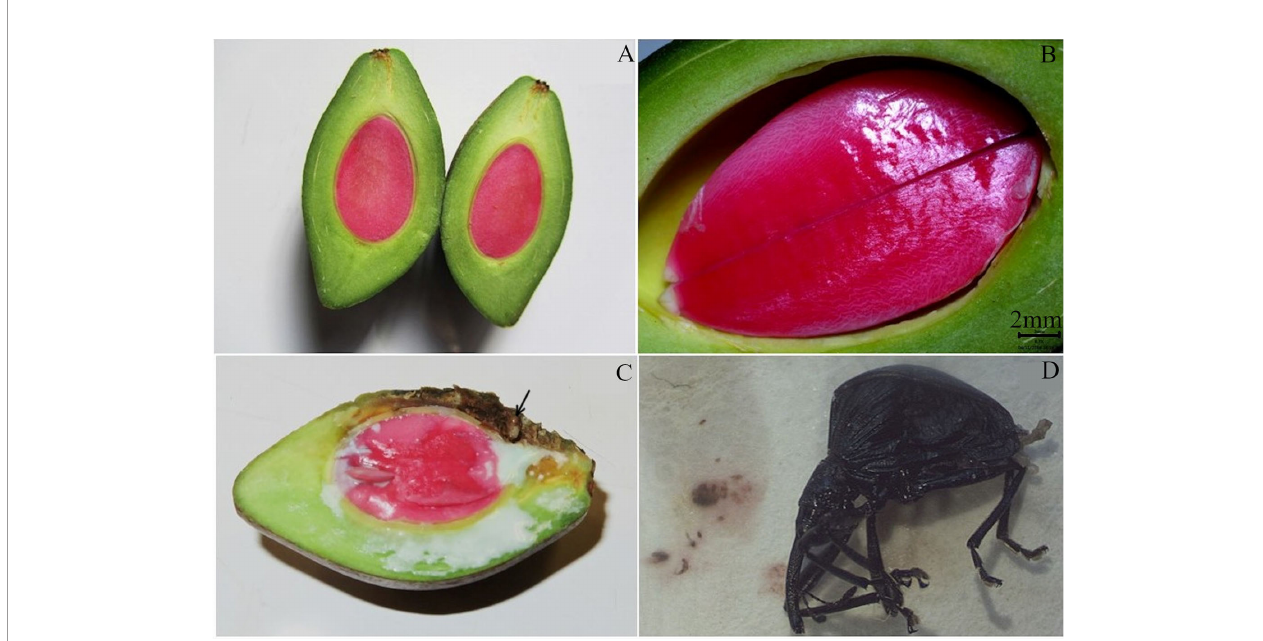
FIGURE 5 | Cut fruit of Pycnandra acuminata (A) , showing detail of the seed, note laticifer network visible in the cotyledons (B) , and (C) exuding latex and Apionidae larva (black arrow). (D) Adult Apionidae that developed within the fruit. The pressed insect had a positive dimethylglyoxime impregnated-paper staining (red/brown stained), revealing it high Ni content (>1,000 µg g − 1